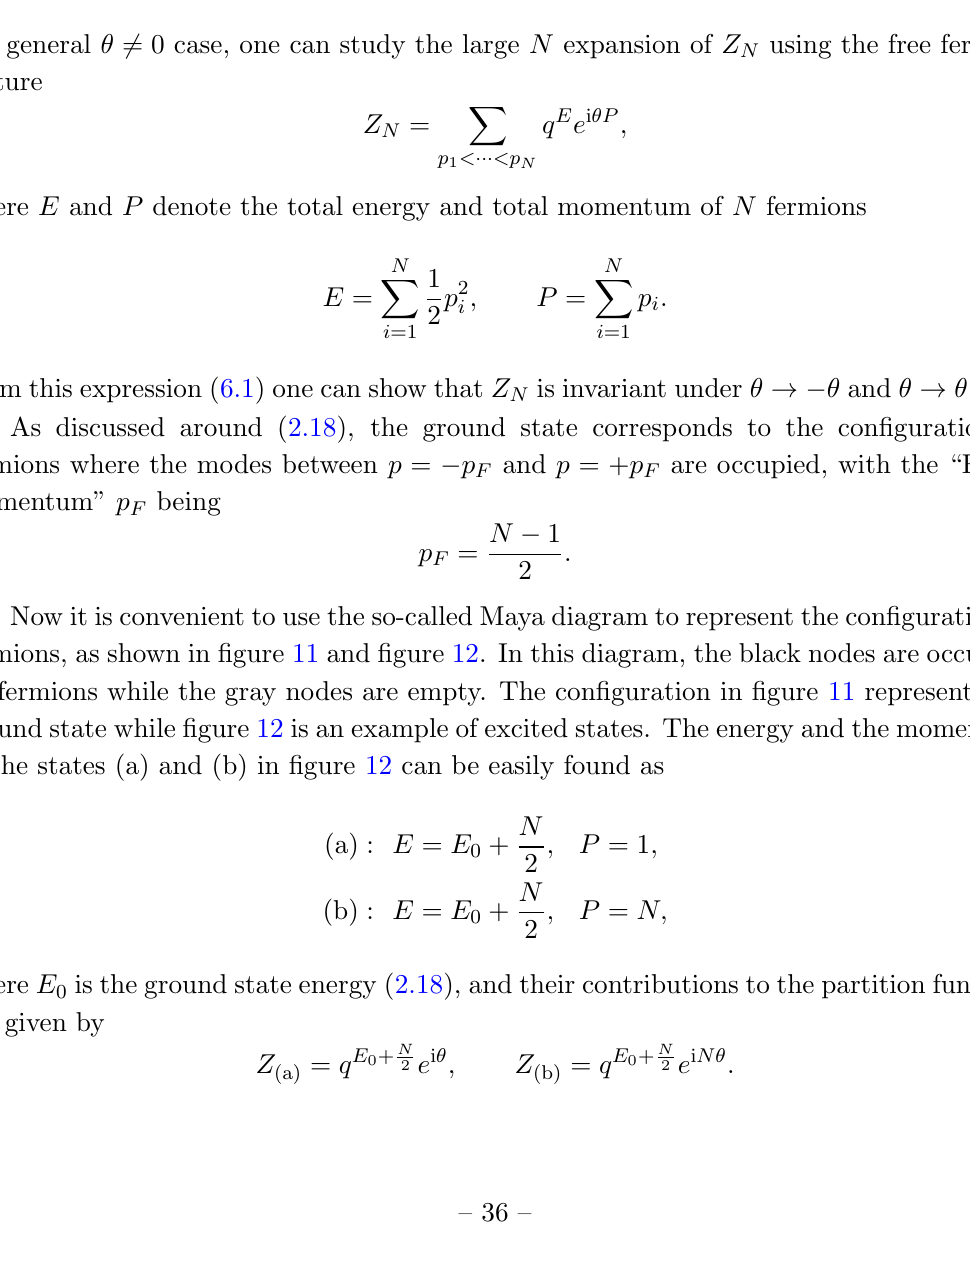
Figure 10 . Relative deviations of the lateral Borel resummation S + ( e Z full ) from the nonpertur- q 2 (cid:25) bative result e Z N + i Z N +1 at g s = 2. The real part (left) and the imaginary part (right) are g s plotted